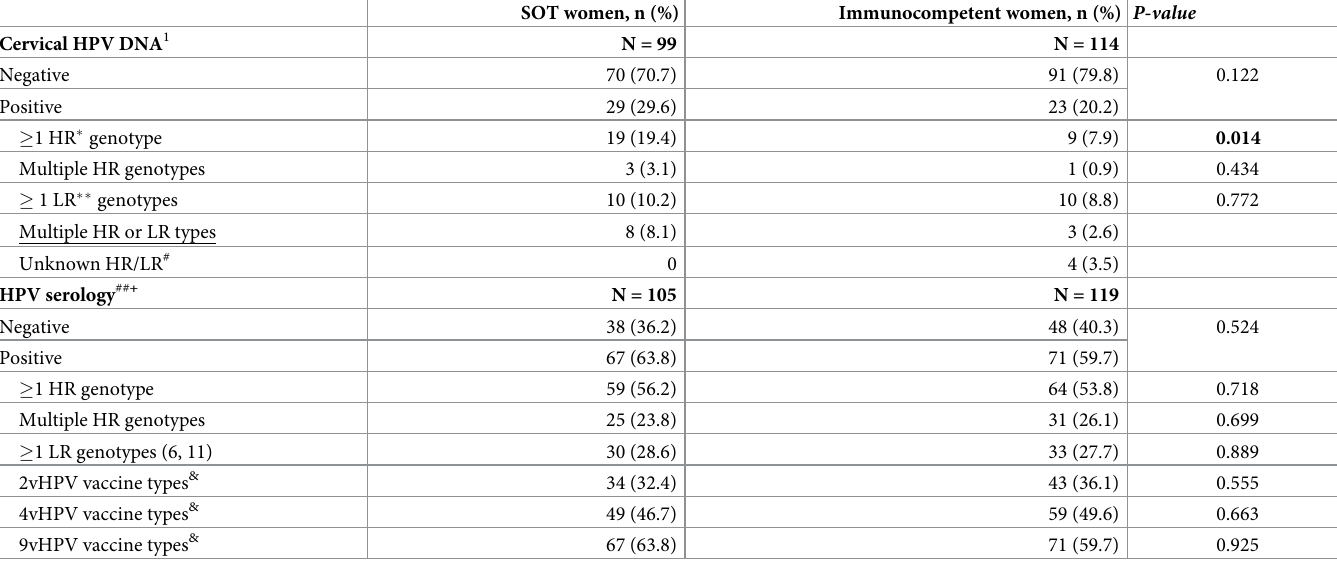
Table 2. Results of HPV-DNA PCR in cervical samples and HPV serology (PseudoVirion-Luminex), according to study population.